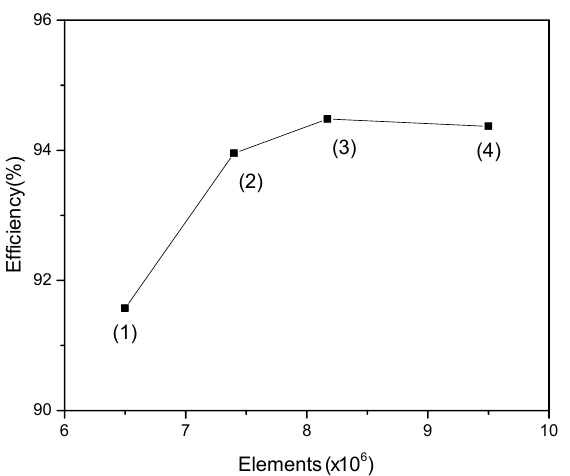
Figure 6. Mesh of the fluid domains.